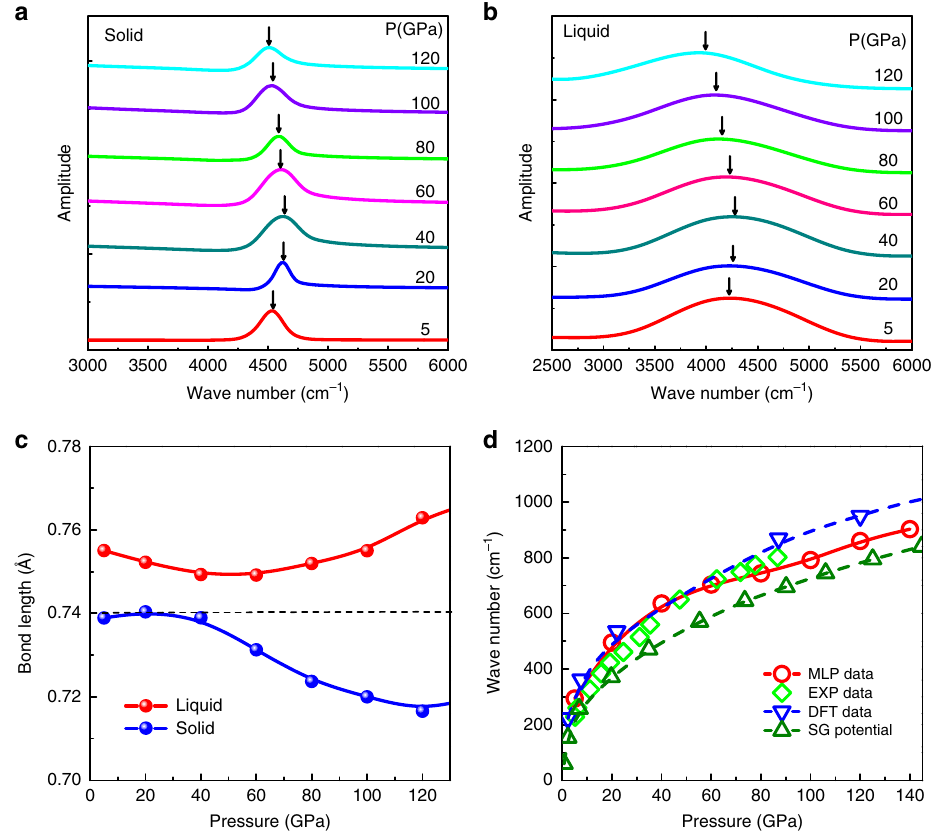
Fig. 2 Calculated Raman signals of solid and liquid H 2 as a function of pressures. a Pressure dependence of vibron frequencies from the solid H 2 at T = 150 K, arrows emphasise the turnover of the peak frequency. b Pressure dependence of vibron frequencies from the liquid H 2 at T = 1000 K. c The mean H – H bond length as a function of pressures, the dotted horizontal line is to guide the eye. d The pressure-dependent E2g phonon frequency compared with our DFT, recent experiments 58,46 , and Silvera – Goldman potential 43,44 .